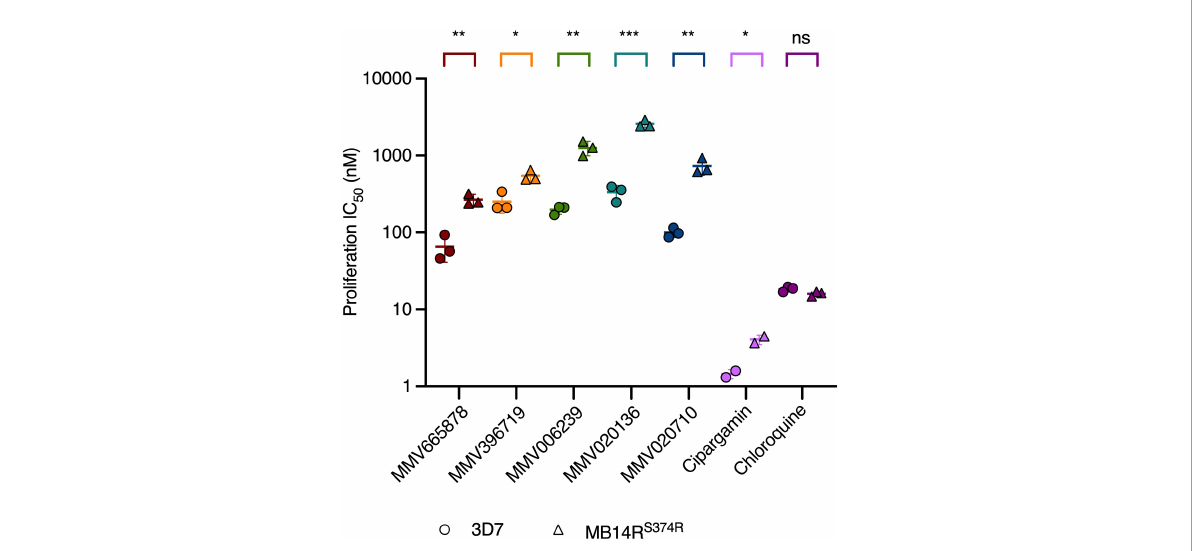
FIGURE 1 Pf ATP4-mutant MB14R S374R parasites are cross resistant to multiple Pf ATP4 inhibitors but not to the mechanistically unrelated antimalarial chloroquine. MB14R S374R parasites (triangles) and the parental 3D7 parasite line (circles) were treated with a 2-fold dilution series of each test compound and incubated for 72 h. Lactate dehydrogenase activity was then measured as an indicator of parasite biomass and the IC 50 for proliferation was estimated. Lines and error bars indicate the mean IC 50 ± SD of three biological replicates (except for cipargamin, for which two biological replicates were conducted), each consisting of technical triplicates. The statistical signi fi cance of the difference between the mean IC 50 s for the two parasite lines was calculated using the unpaired Student ’ s t-test (ns: not signi fi cant, *p<0.05, **p<0.01, ***p<0.001). IC 50 values, fold differences and p-values are listed in Supplementary Table